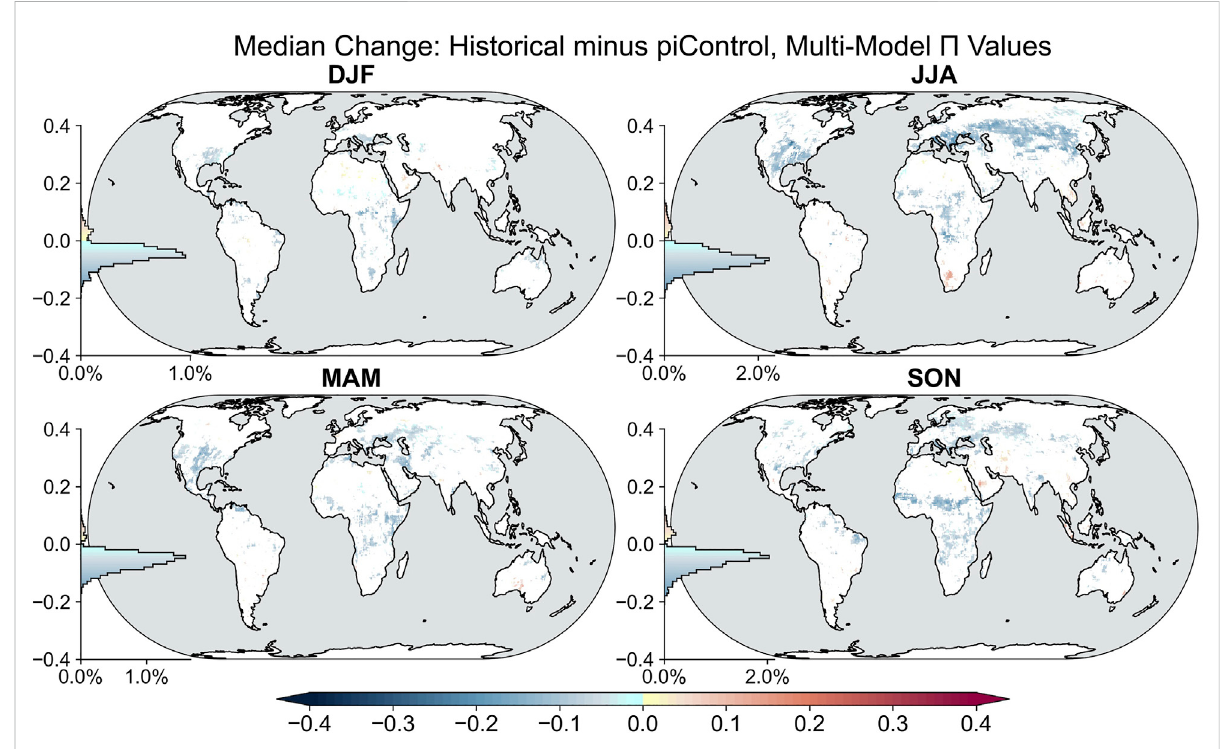
FIGURE 2 Multimodelmedianchangein Π (dimensionless)foreachseasonfrompiControltothelast50 yearsofthehistoricalsimulationsinCMIP6.Areas are masked where the agreement among models on the sign of the change is below the 99% con fi dence level, or where the median of seasonal mean near-surface air temperature is below 0 ° C. Histograms show the probability distribution of signi fi cant changes as a fraction of the total land